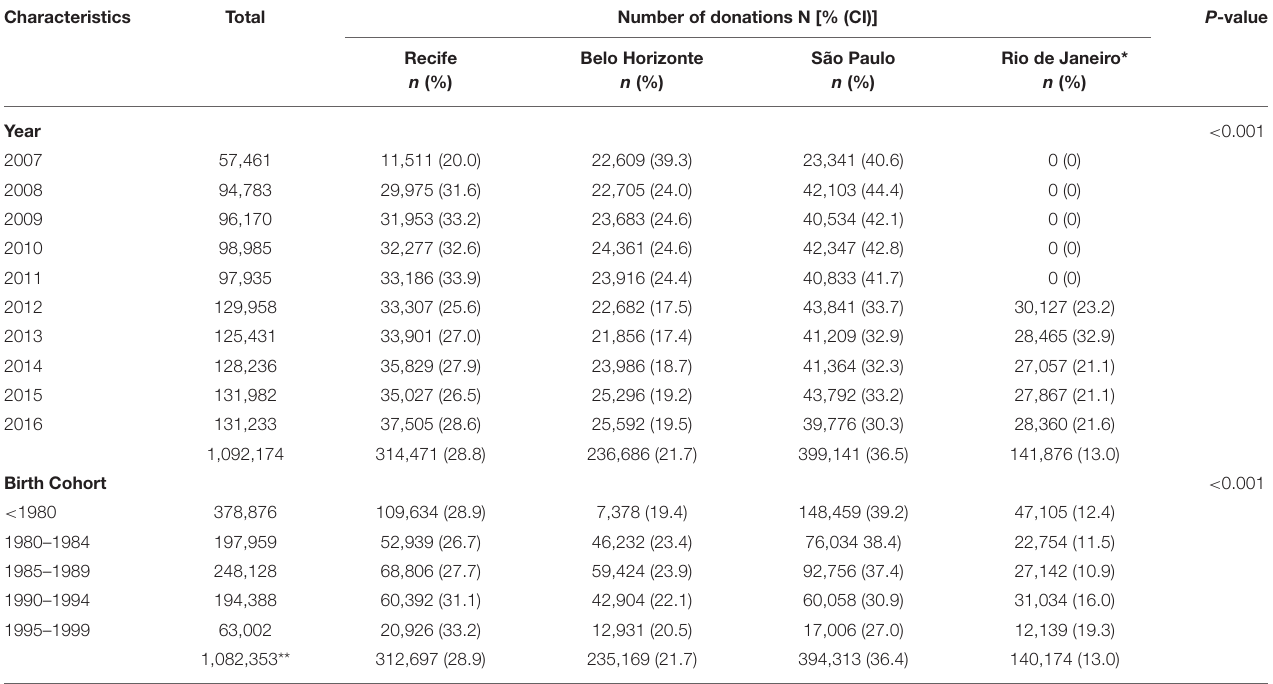
TABLE 1 | Number of first blood donations that were collected from January 2007 to December 2016, by year of collection, birth cohort, and blood center location.